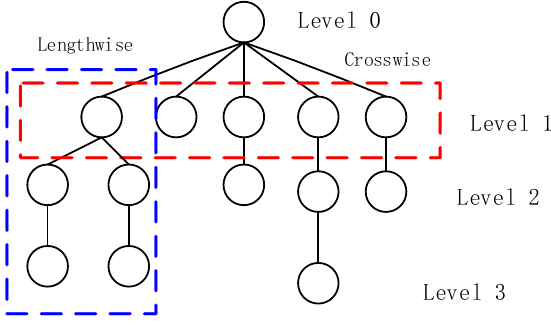
Figure 6. Tree structure analysis .